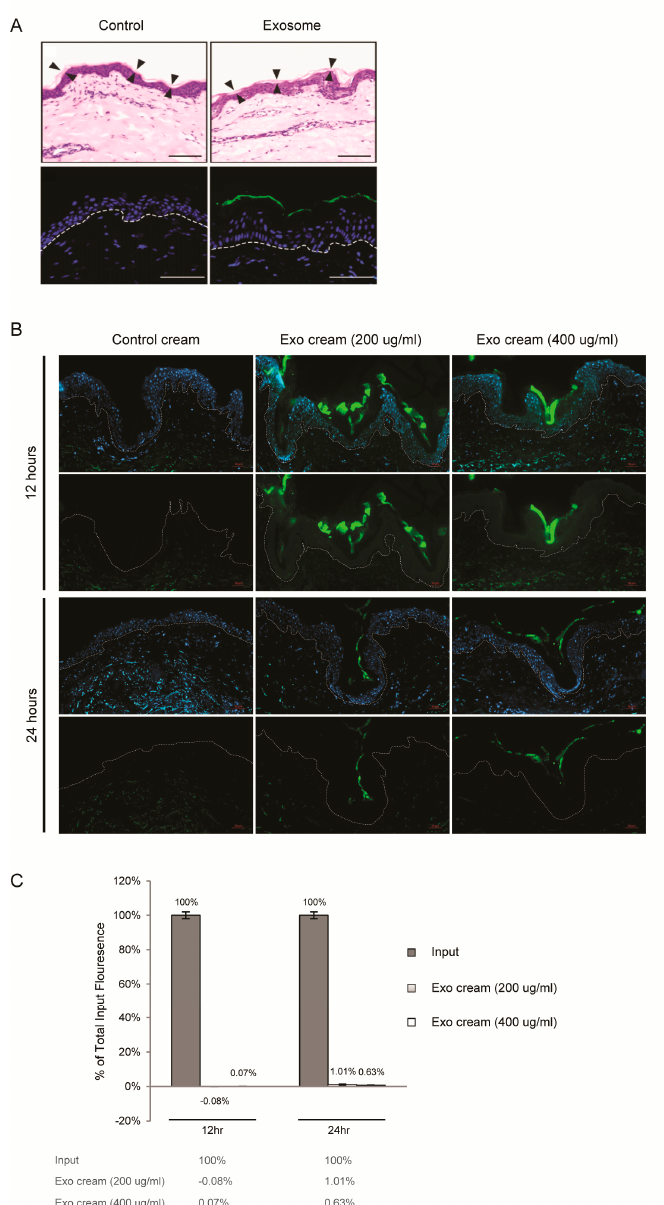
Figure 5. Dermal penetrance of MSC exosomes ( A ) Topical application of MSC exosomes (aqueous) on human skin explant culture. Human skin explant was topically treated with PBS (Control) or Alexa Fluor 488-labeled exosomes, washed, frozen in OCT medium and sectioned. (Upper panel) H&E staining with arrowheads indicating boundary of the stratum corneum. Scale bar = 100 µ m. (Lower panel) Fluorescence imaging of sections counterstained with DAPI (blue) to show nuclei. White broken lines denote epidermal-dermal junction. Scale bar = 50 µ m. ( B ) Topical application of exosome oil-in-water emulsion cream on skin explant culture. Human skin explant culture was topically treated with AF488-labeled PBS (control cream) or AF488-labeled exosome cream (200 µ g/mL or 400 µ g/mL) for 12 and 24 h, washed, frozen in OCT medium and sectioned. Fluorescence imaging of sections counterstained with DAPI (blue, upper panel) or without DAPI (lower panel). White broken lines denote epidermal-dermal junction. Scale bar = 50 µ m ( C ) Relative AF488 signal in culture medium of skin explants to input fluorescence. After subtracting the AF488 signal in the label control cream, the fluorescence signal in the culture of explants treated with exosome cream (200 µ g/mL or 400 µ g/mL) was normalized to their respective input signals to calculate the percentage of total input fluorescence in culture medium of skin